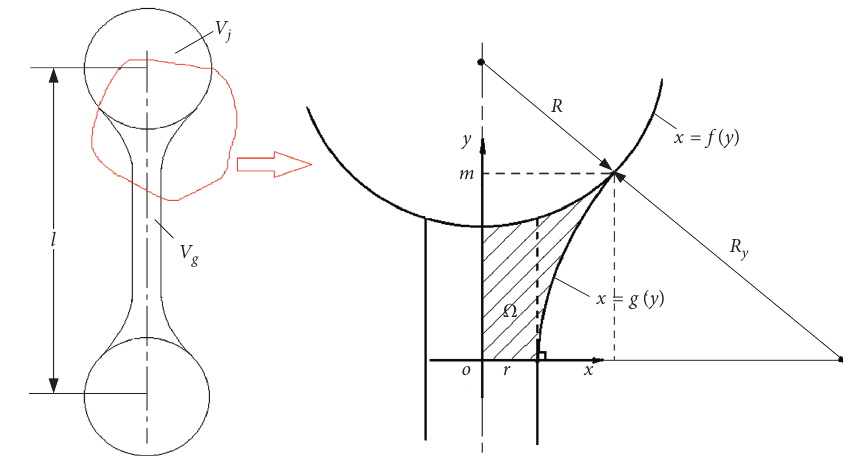
Figure 4: Model of fillet connection between node and rod. Table 1: Calculation process of relative